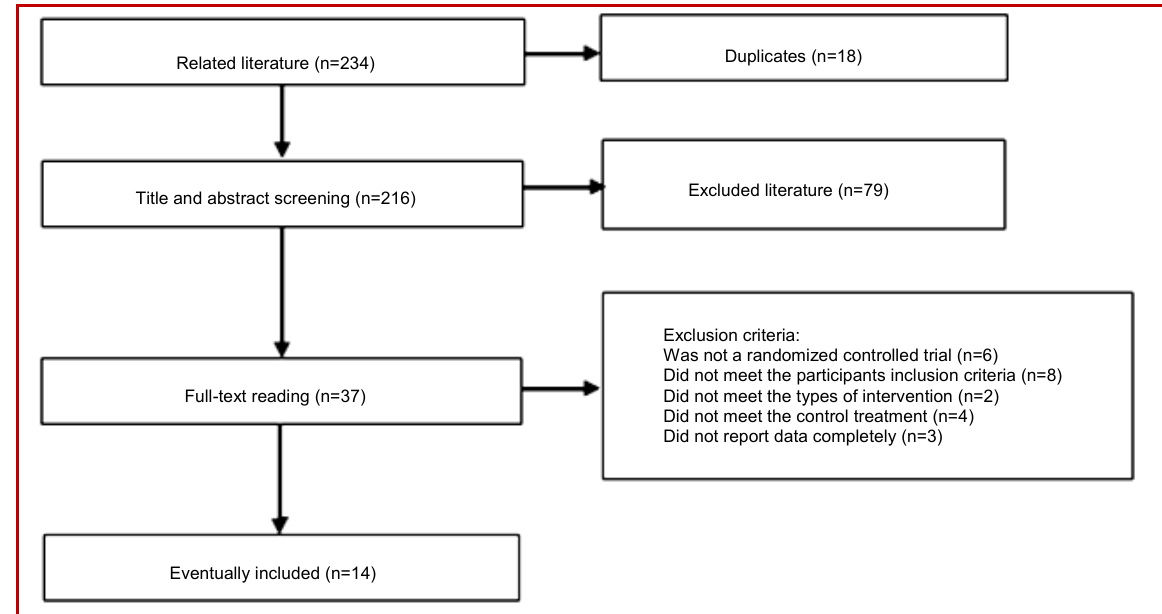
Figure 1: Flow diagram for literature screening and selection